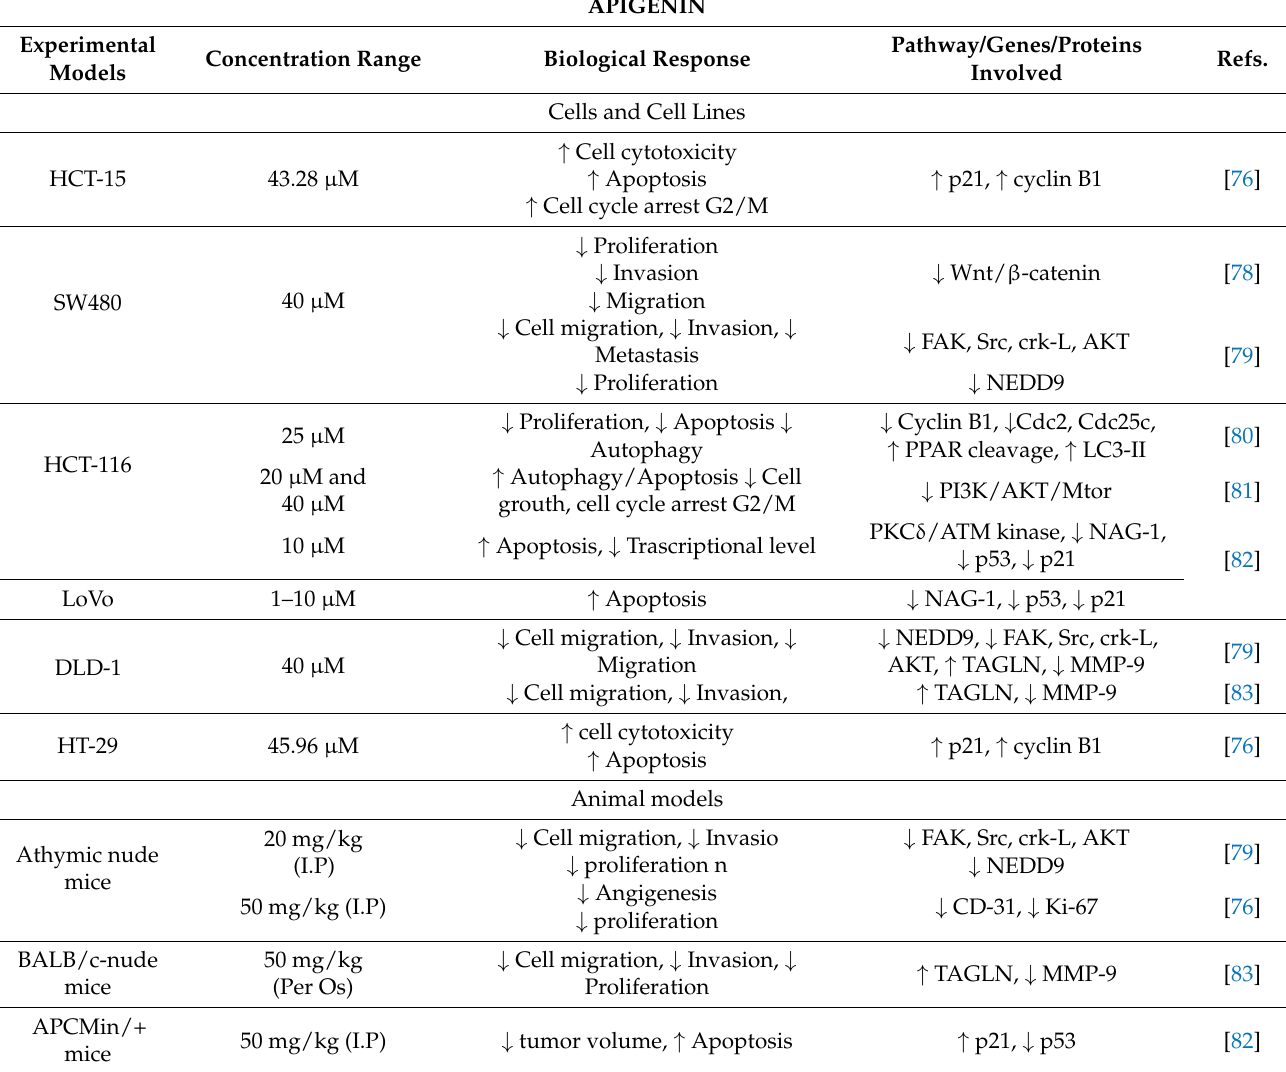
Table 4. Antitumoral effects of apigenin in colorectal